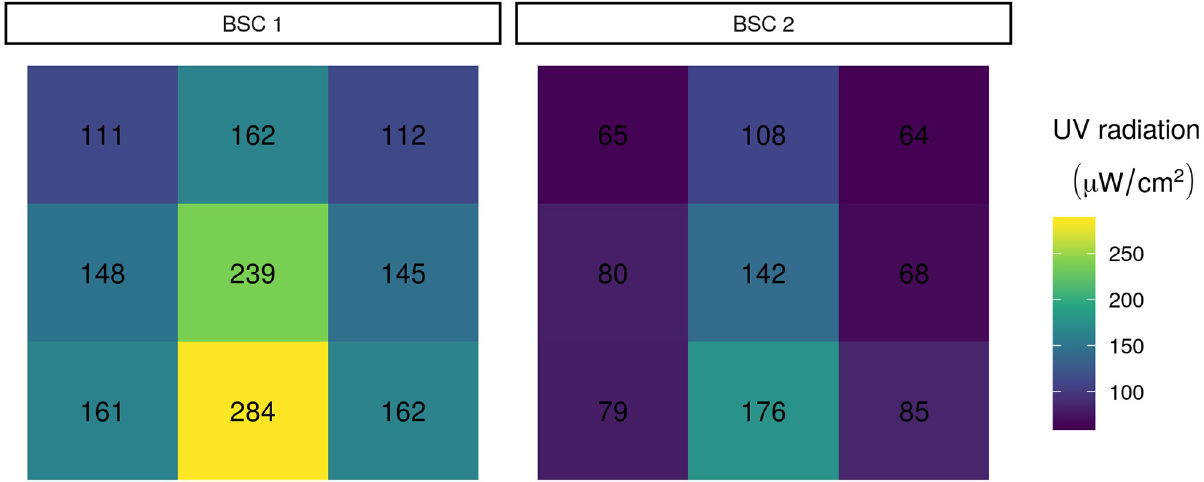
Fig 1. UV radiation in each sector of each BSC as measured with a UV meter. Each of the nine sections per BSC shows the UV radiation measured in the section. Numbers indicate UV radiation measured in each section.